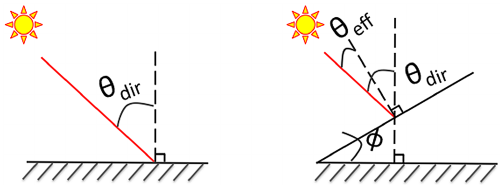
Figure 4. The effective solar zenith angle, θ eff , is the same as the solar zenith angle of direct solar radiation, θ dir , on a flat surface (left). However, on a surface that has an incline (right) the effective solar angle, θ eff , is the difference of the direct solar zenith angle and the angle of the surface, φ , and typically